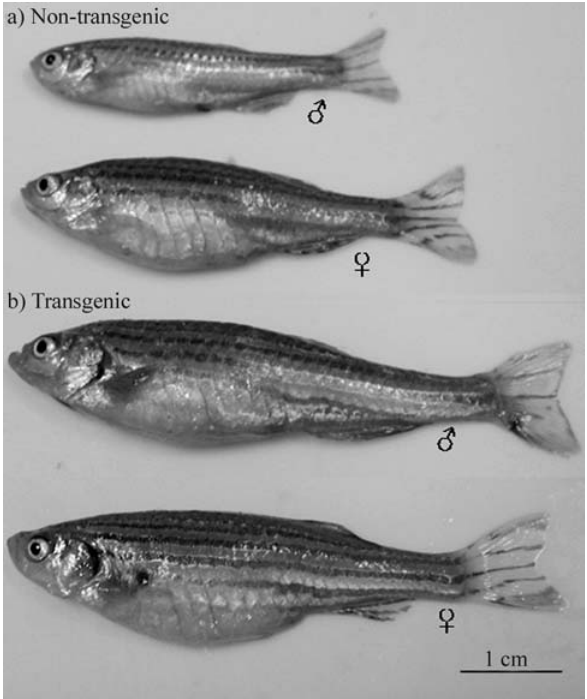
Figure 1 - Zebrafish ( Danio rerio ): (a) one-year old non-transgenic fish (averageweight=0.68±0.13)and(b)one-yearoldG 0 transgenicfish(av- erage weight = 1.79 g ±